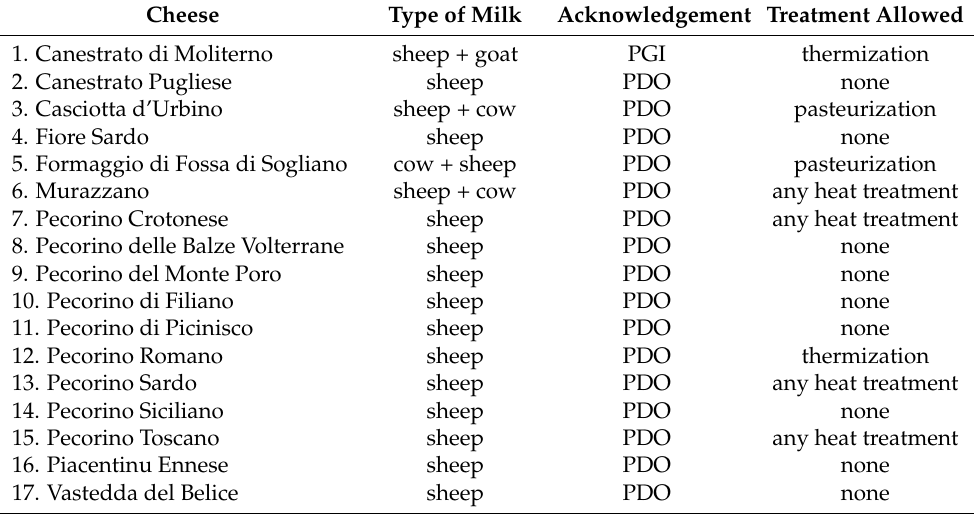
Table 1. PDO and PGI Italian cheeses made from sheep milk (alone or in combination) and heat treatments